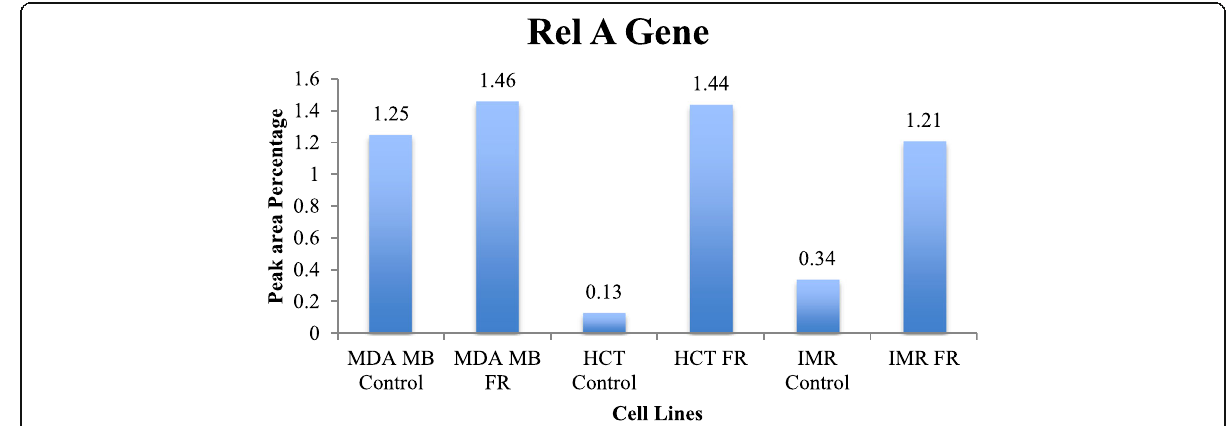
Fig. 15 The relative gene expression of Rel A gene in all the cell lines. FR — Ficus religiosa